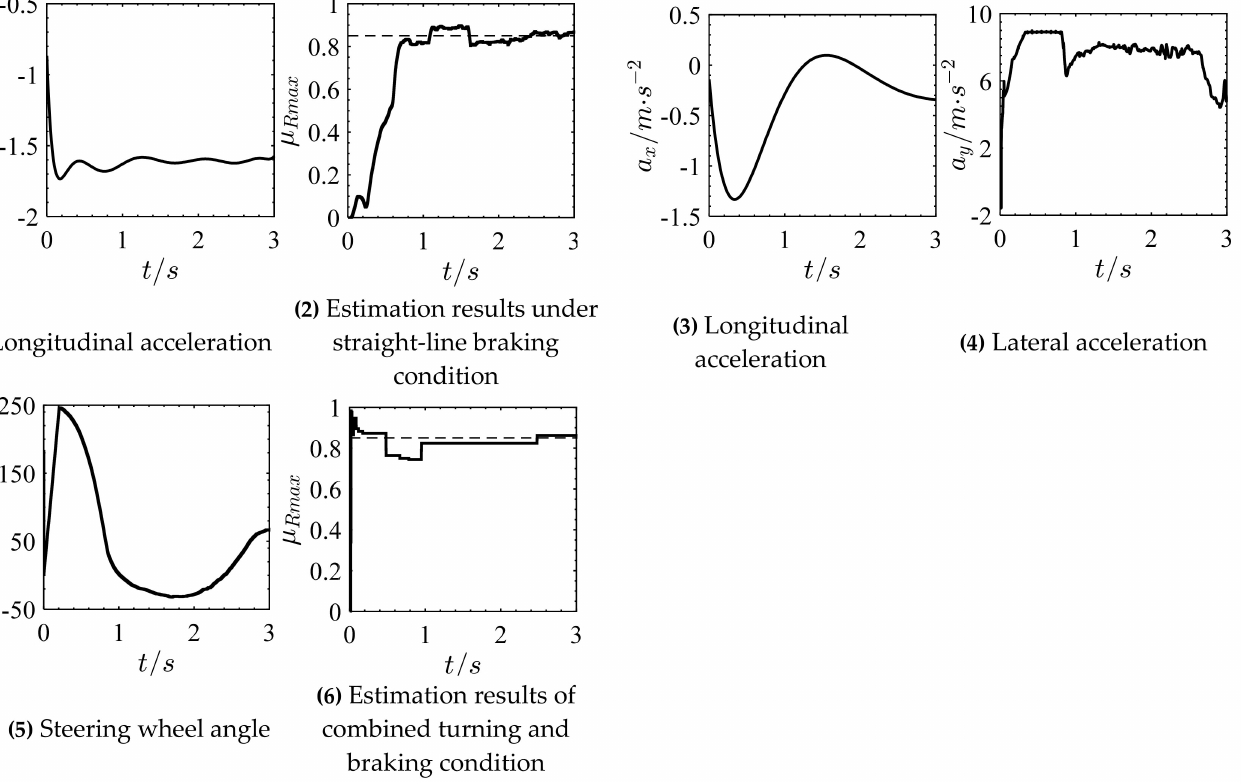
Figure 7. Simulation